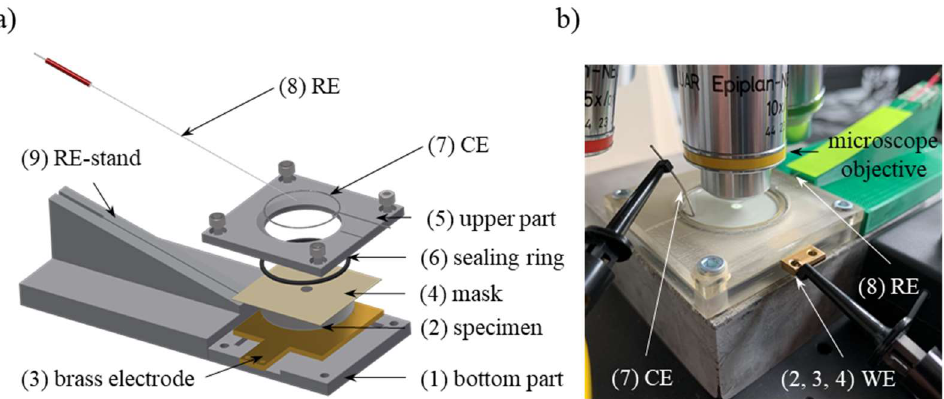
Figure 2. Exploded drawing ( a ) and optical image ( b ) of the micro-corrosion cell consisting of a working electrode (WE) (2, 3, 4), reference electrode (RE) (8), counter electrode (CE) (7), sealing ring (6), upper part (5), mask (4), brass electrode (3), specimen (2) and a bottom part (1).